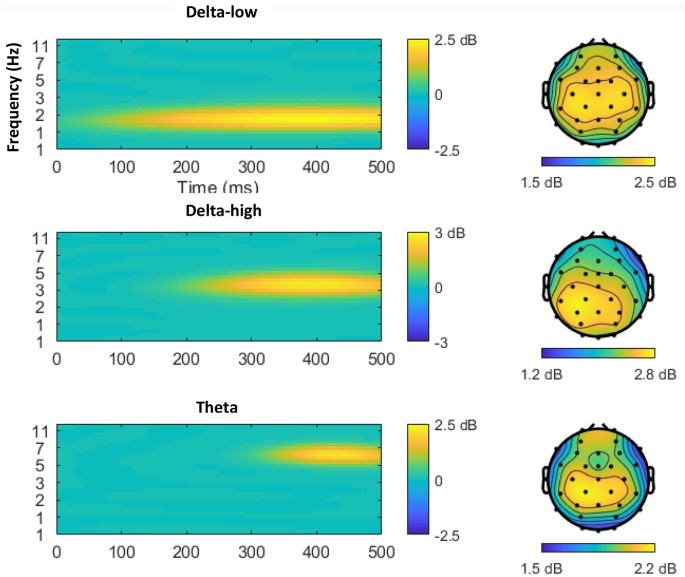
Time-frequency-spatial principal component analysis (PCA) revealed three factors in the delta to theta frequency bands within the time range of the reward positivity (RewP). From top to bottom, the three factors are ordered by the percentage of variance explained from largest to smallest. The left column depicts the time-frequency power spectrum of each factor, with yellow indicating higher power. The right column depicts the scalp distribution of the corresponding factor.